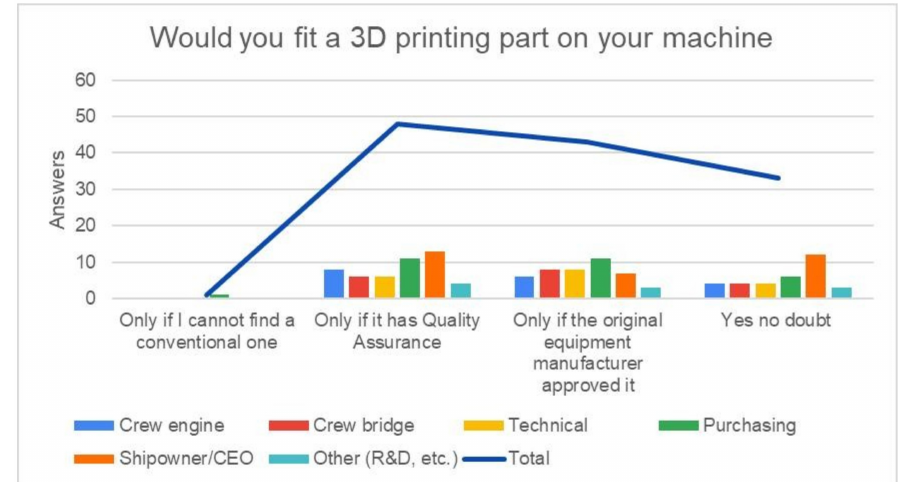
Figure 7. Response to the question “Would you fit a 3D printing part on your machine”.